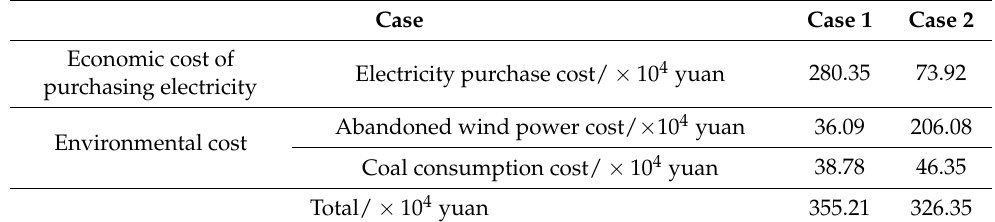
Table 5. Operating costs of the two cases.